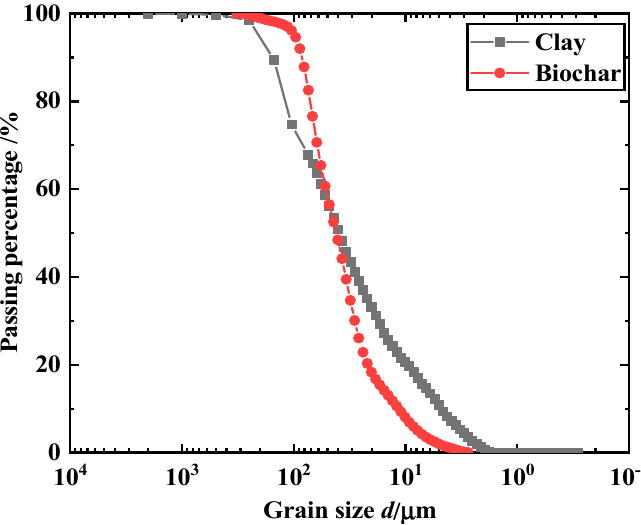
Figure 2. Grain − size distributions of the clay and biochar. Figure 2. Grain–size distributions of the clay and biochar. The soil from the Shanghai Laogang landfill covering layer was mixed with deion- ized water, to separate the bacteria from the soil and dissolve the bacteria in the wa- ter. The supernatant was taken after shaking, to prepare the inorganic salt culture so- lution for screening for methanotrophs. The components of the inorganic salt cultures were, MgSO 4 · 7H 2 O (1.0 g), KNO 3 (1.0 g), Na 2 HPO 4 · 2H 2 O (0.717 g), KH 2 PO 4 (0.272